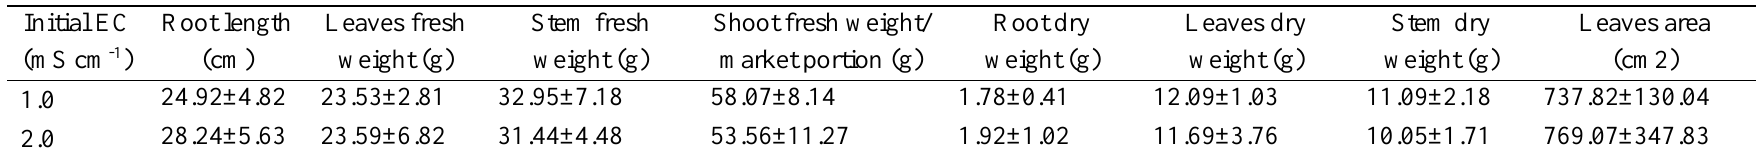
Table 12. Effect of initial electrical conductivity on root length, leaves fresh weight, stem fresh weight, shoot fresh weight (market portion), root dry weight,